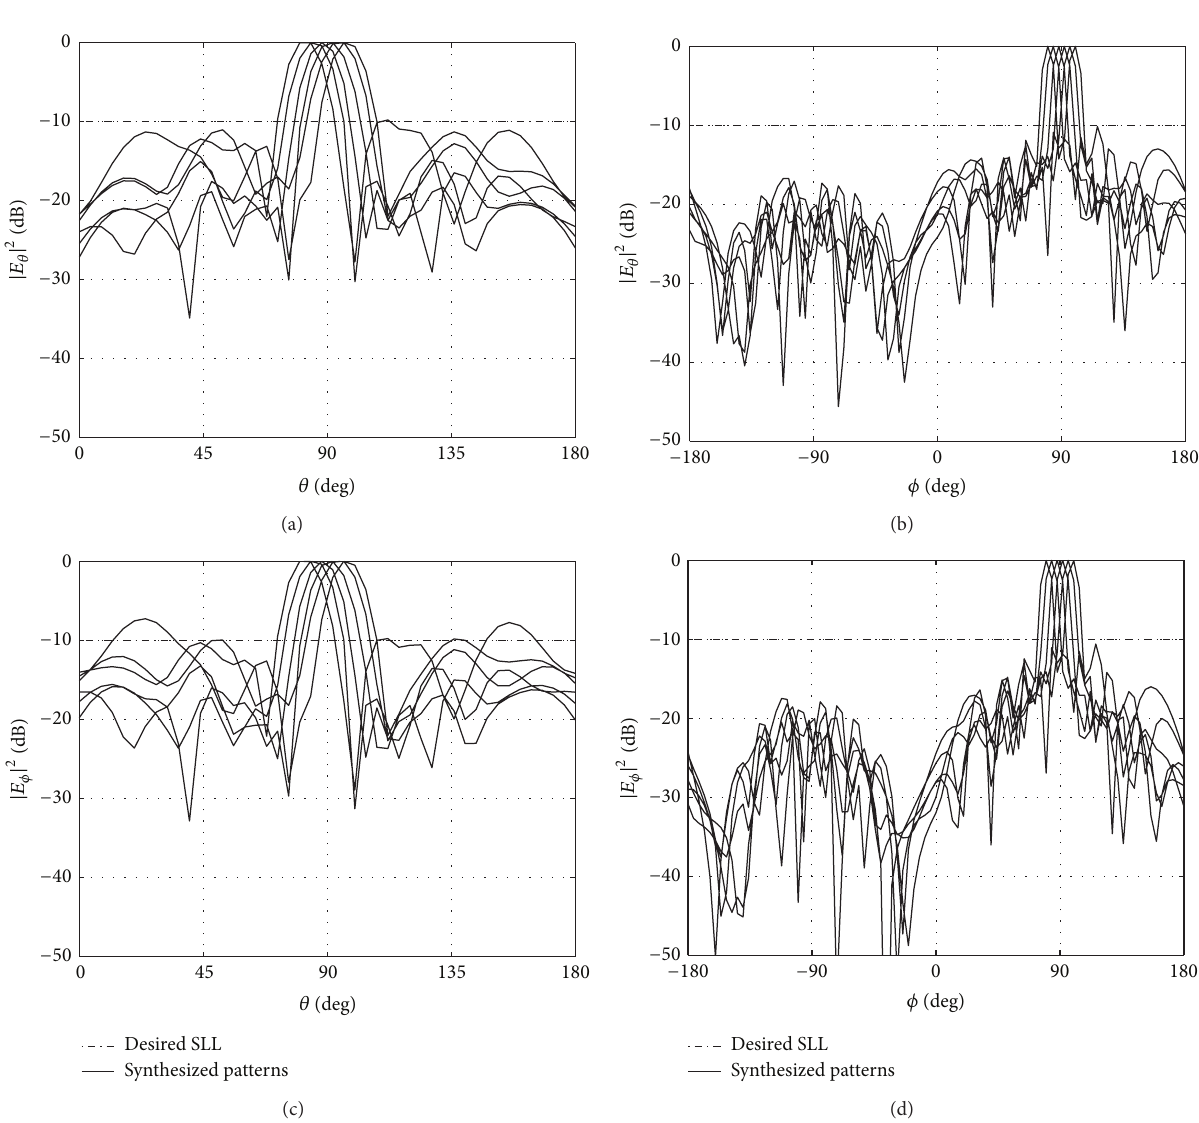
Figure 3: Patterns obtained for a two-dimensional scanning of the region [80 ∘ ,100 ∘ ]×[8 ∘ , 100 ∘ ] using the proposed algorithm by phase-only control with 𝑐 = 0.1 : (a) |𝐸 𝜃 | 2 for 𝜙 = 88 ∘ , (b) |𝐸 𝜃 | 2 for 𝜃 = 88 ∘ , (c) |𝐸 𝜙 | 2 for 𝜙 = 88 ∘ , and (d) |𝐸 𝜙 | 2 for 𝜃 = 88 ∘